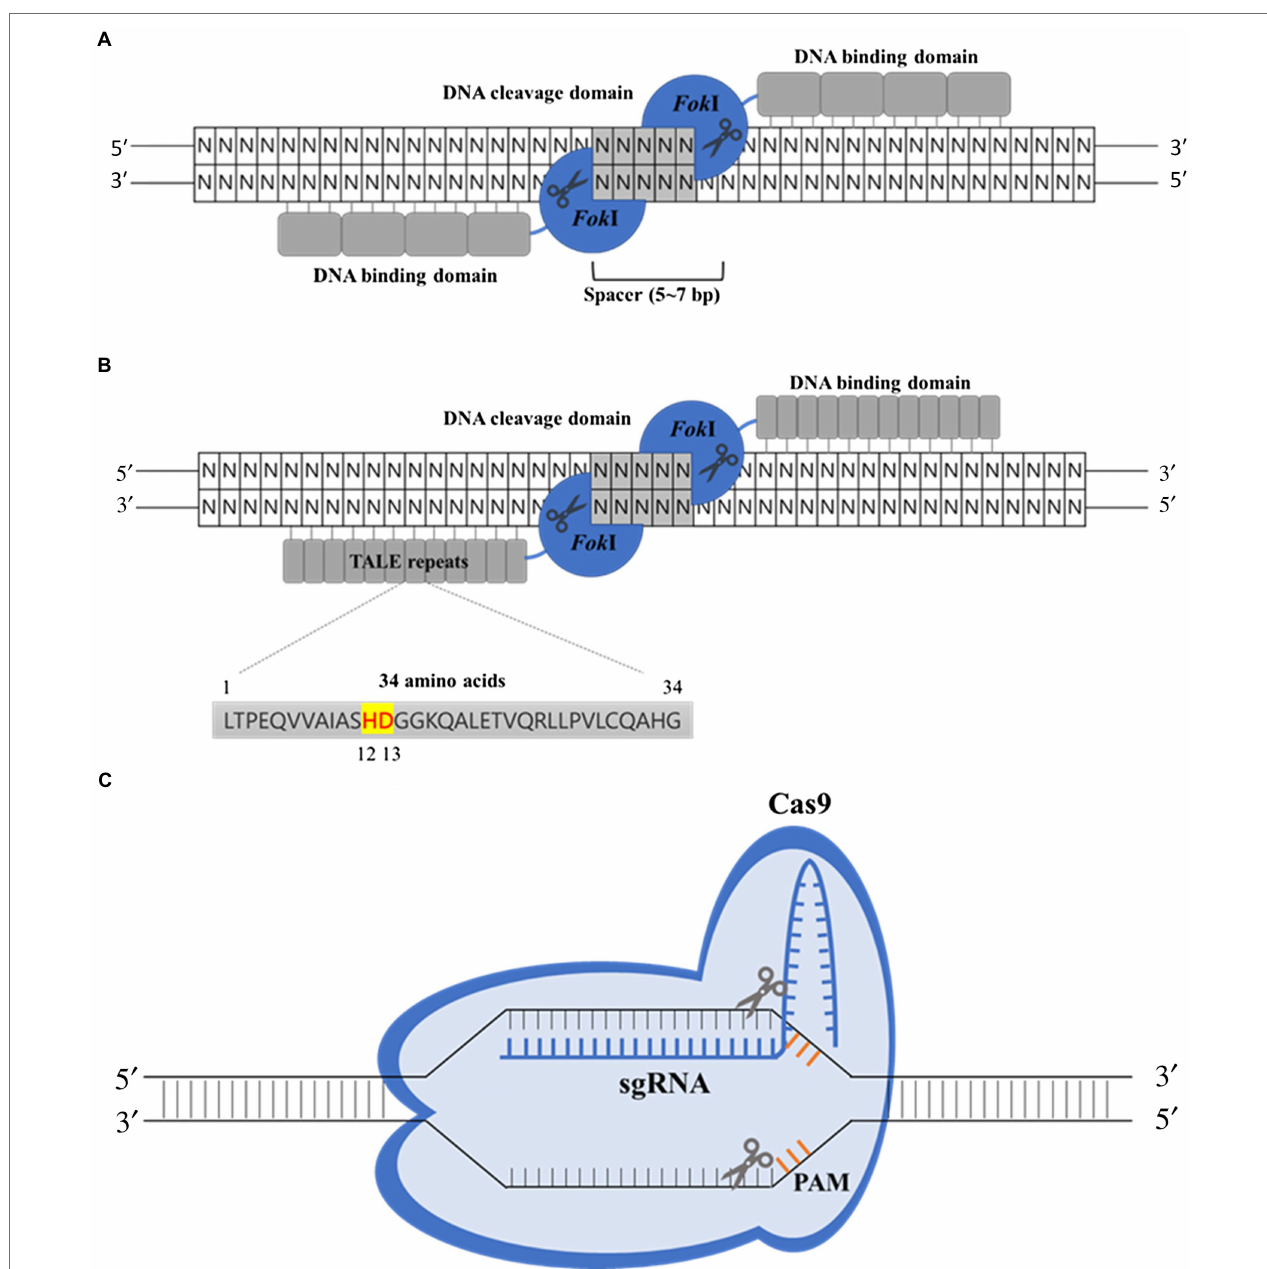
FIGURE 1 | Some of the major genome-editing technologies using site-specific nucleases include zinc-finger nucleases (ZFNs), transcription activator-like effector nucleases (TALENs), and the clustered regularly interspaced short palindromic repeats/CRISPR-associated 9 (CRISPR-Cas9) systems. (A) The ZFN-binding domain is comprised of multimerized zinc-finger proteins (ZFPs). Each ZFP recognizes approximately 3 bp of DNA sequence, and the fused Fok I nuclease domains dimerize and generate double-strand breaks. (B) Like ZFNs, TALENs consist of a DNA-binding domain, termed transcription activator-like effector (TALE) repeats, and nuclease domain of Fok I enzyme. Each TALE repeat consists of a highly conserved 34-amino acid sequence with hypervariable twelfth and thirteenth amino acids, which allow the recognition of the single nucleotide. (C) In the CRISPR-Cas9 system, a single-guide RNA (sgRNA) guides the Cas9 nuclease to direct the cleavage of cognate DNA sequences adjacent to 5 ' -NGG-3 ' protospacer-adjacent motifs